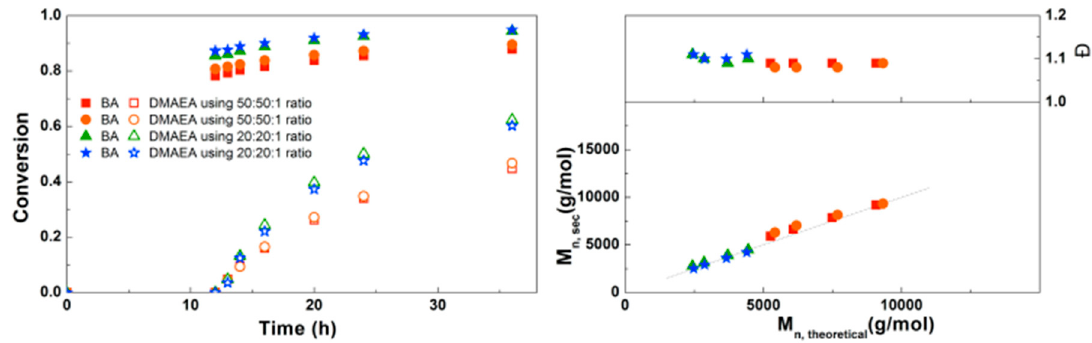
Figure 7. ( Left ): conversion versus time plot for Cu(0)-mediated one-pot block copolymerization of BA and DMAEA using [BA]:[DMAEA]:[CPE]:[Me 6 TREN]:[CuCl 2 ] = 50:50:1:0.3:0.2 and [BA]:[DMAEA]:[CPE]:[Me 6 TREN]:[CuCl 2 ] = 20:20:1:0.3:0.2, 3.0 M in DMF at 25 °C and 12.5 mm 2 /mL Cu(0) wire. A 3.0 M solution of DMAEA in DMF was added after 12 h reaction time. ( Right ) corresponding molecular weight and dispersity versus theoretical molecular weight plot.